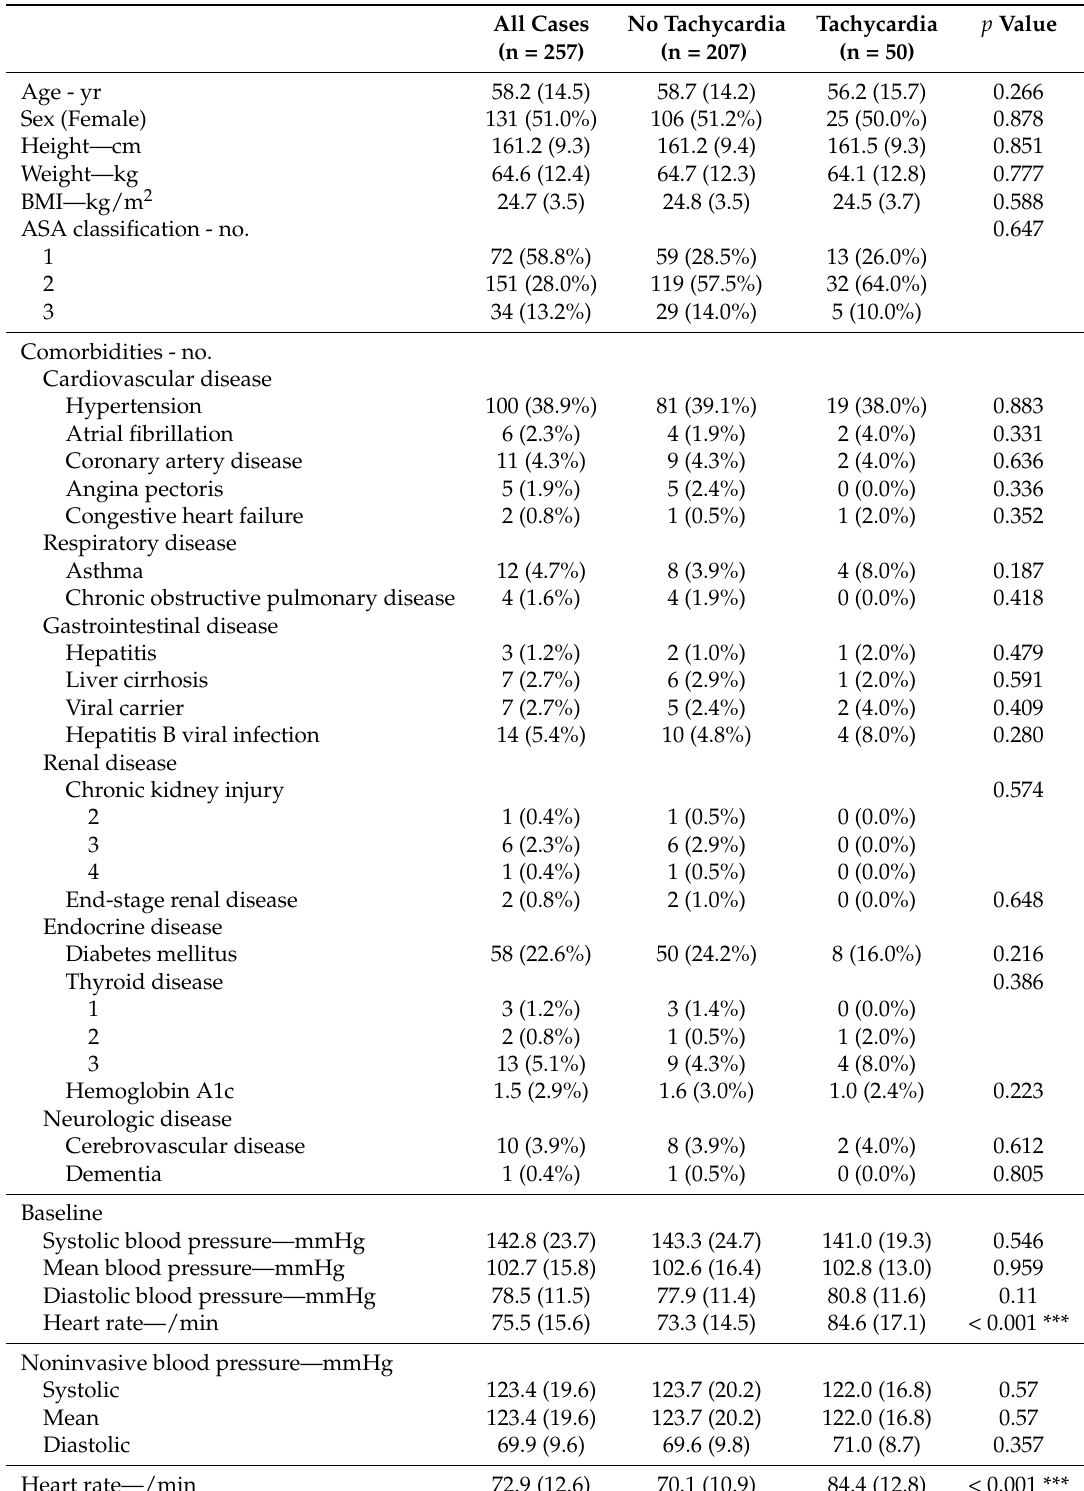
Table 3. Statistical characteristics of